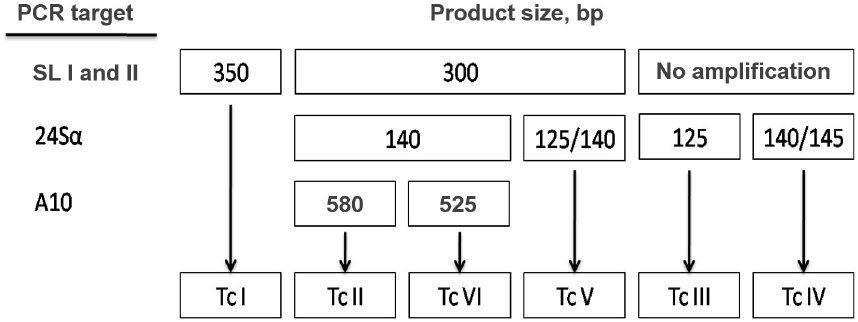
Fig 3. Multilocus conventional PCR flowchart for T . cruzi genotyping directly from human blood samples, based on three molecular markers. The flowchart indicates PCR product size in bp. SL-IR I and II: spliced-leader intergenic region I and II. 24S α : heminested amplification of the D7 domain of 24S α ribosomal RNA genes. A-10: heminested reaction for the A-10